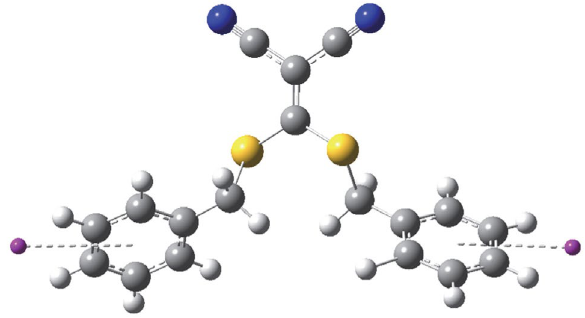
Figure 2. Typical structure of thioethers 4a–h